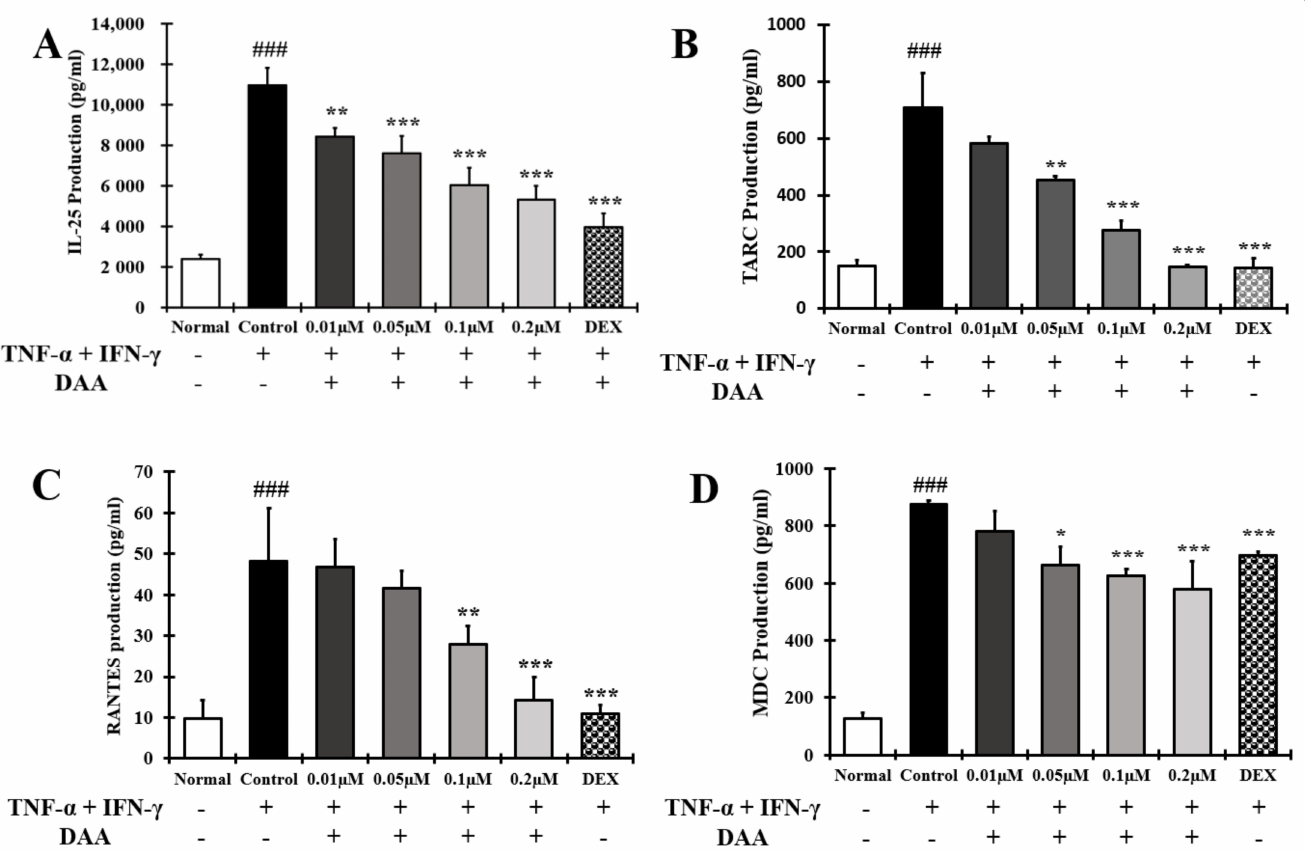
Figure 7. Effect of DAA on the levels of AD-related cytokines and chemokines known to activate Th2 cells secreted by HaCaT cells. The level of cytokine IL-25 ( A ) and chemokines TARC ( B ), RANTES ( C ), and MDC ( D ) in the supernatant of HaCaT cells was evaluated by ELISA. The results are expressed as the mean ± SD (n = 4). ### p < 0.001 vs. normal. * p < 0.05; ** p < 0.01, and *** p < 0.001 vs. control; DAA was used at 0.01 µ M, 0.05 µ M, 0.1 µ M, and 0.2 µ M. DEX, the positive control, was used at 0.1 µ